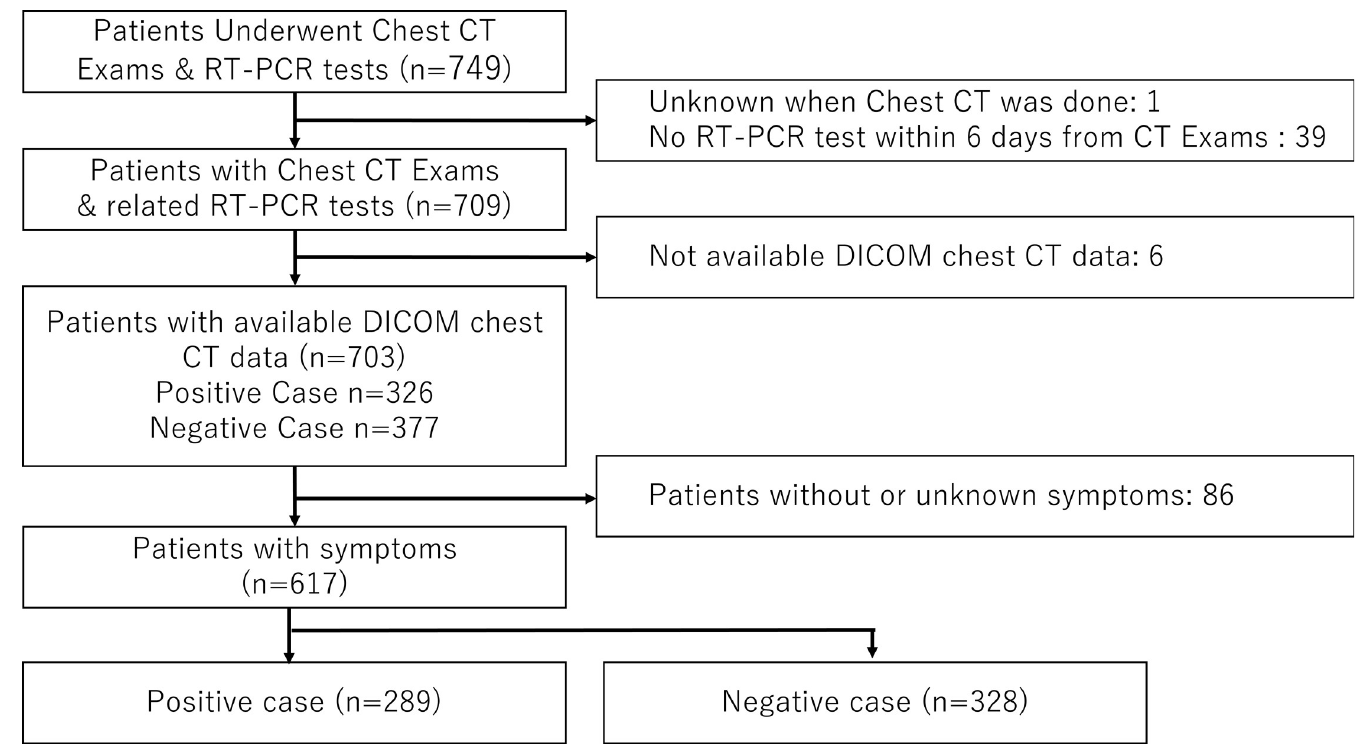
Fig 1. Patient flow. Abbreviations: CT, computed tomography; RT-PCR, reverse transcription-polymerase chain reaction; DICOM, digital imaging and communications in medicine.